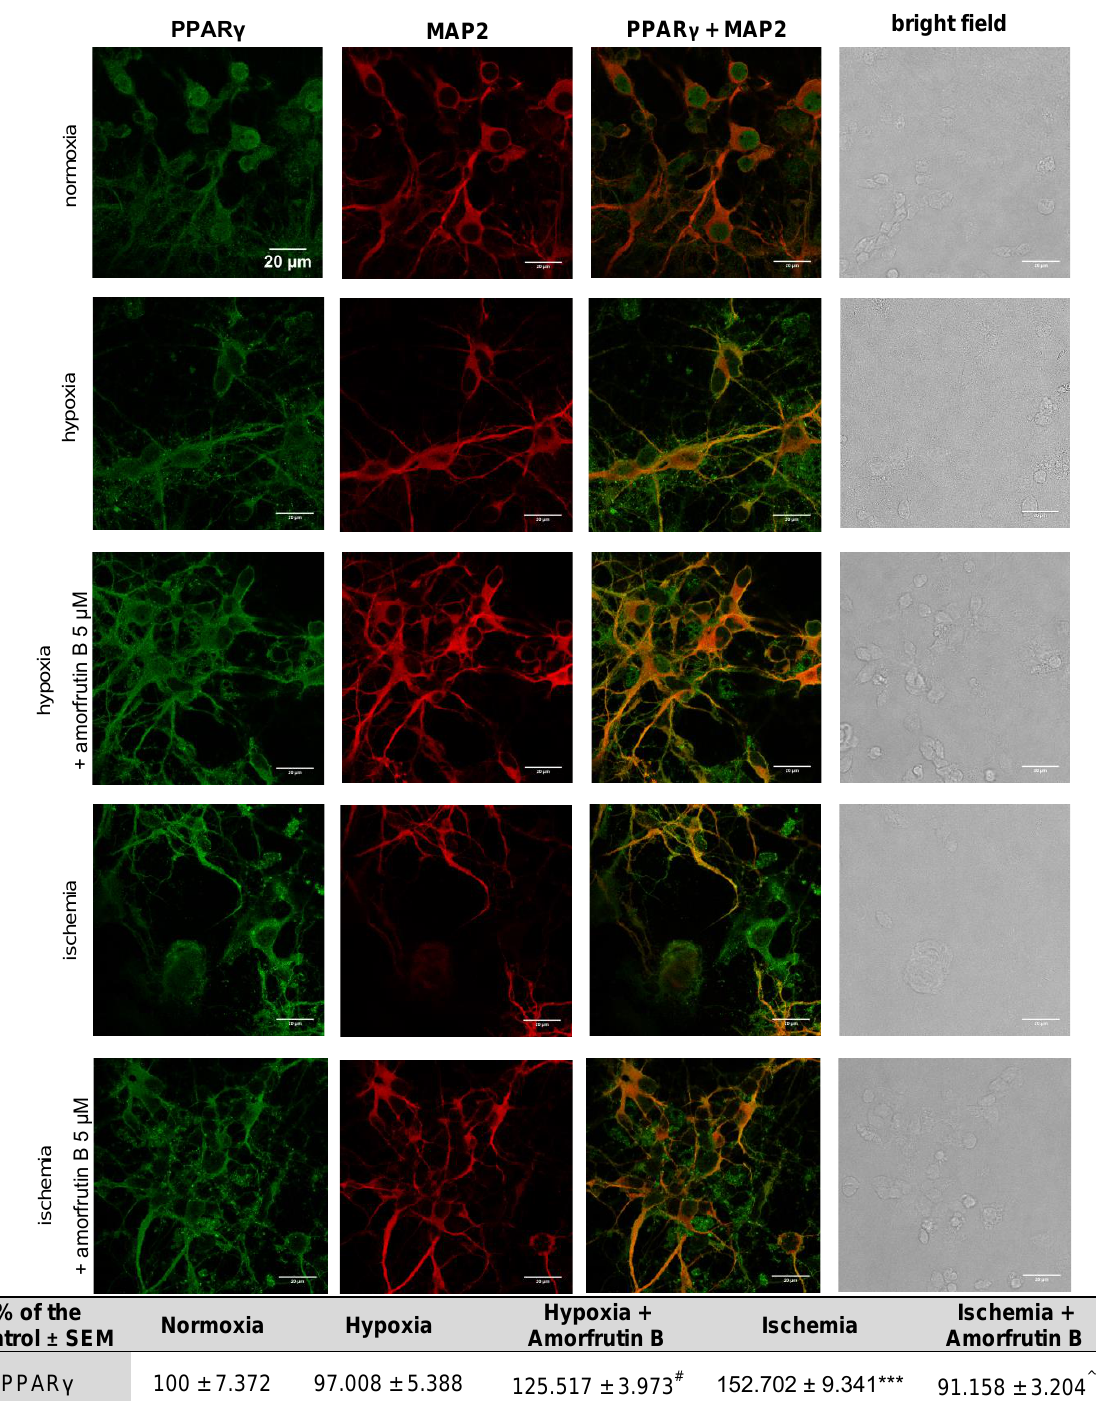
Figure 8. The effect of hypoxia or ischemia and amorfrutin B (5 µ M) post-treatment on immunofluorescence staining of PPAR γ (green staining) and MAP2 (red staining). The bright-field images were also shown. MAP2 confirmed the presence of neuronal cells and showed hypoxia- and ischemia-induced inhibition of neurite outgrowth, reduced by amorfrutin B administration. Staining also showed the distribution of PPAR γ in neuronal cells. The table shows the average pixel intensity for region of interest (ROI). The results are presented as a percentage of the control ± SEM. *** p < 0.001 compared to the control group, # p < 0.05 compared to the cultures exposed to hypoxia, ˆˆˆ p < 0.001 compared to the cultures exposed to ischemia. The number of replicates in each group was